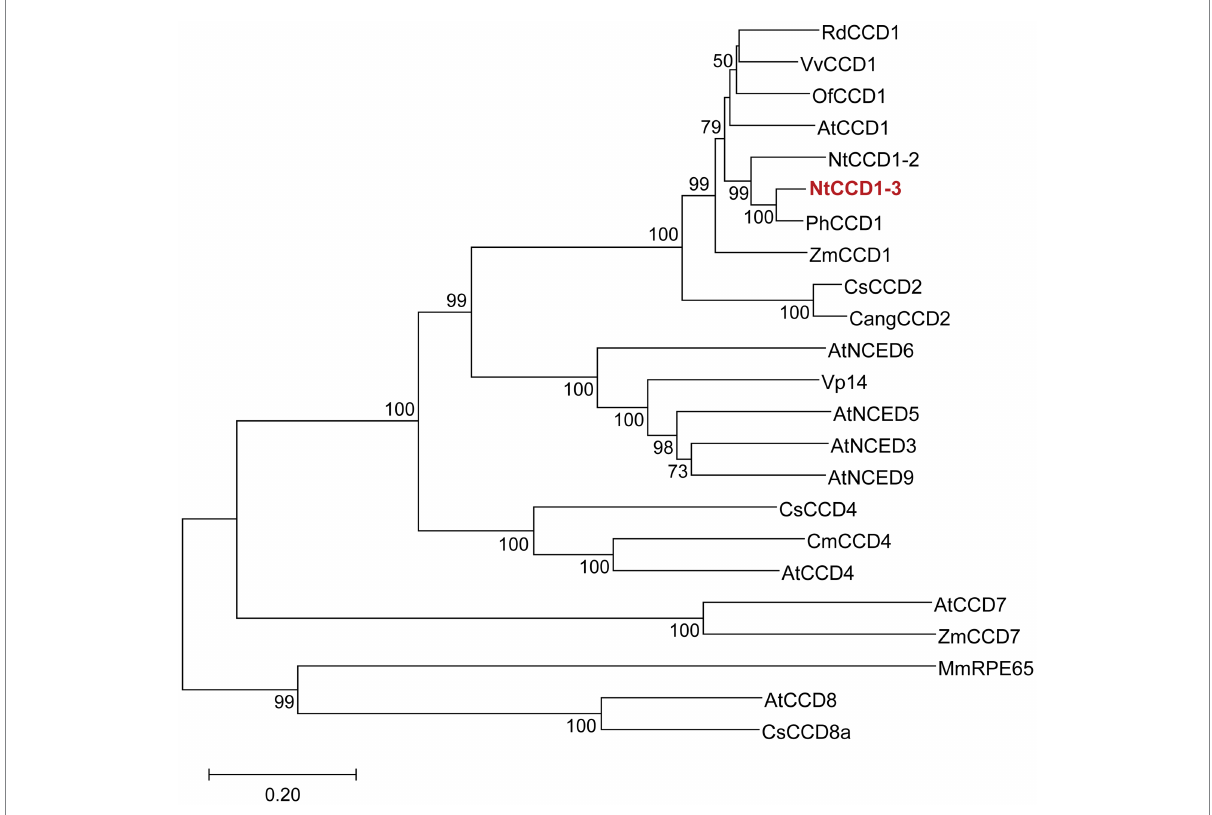
FIGURE 1 Phylogenetic analysis of CCDs from different organisms. NtCCD1-3 is in red and bold. The neighbor joining tree was generated by using MEGA X, based on 1,000 replicates. Bootstrap values above 50 are shown on the branches. The tree scale bar indicates the number of substitutions per site. Rd, Rosa damascena ; Vv, Vitis vinifera ; Of, Osmanthus fragrans ; At, Arabidopsis thaliana ; Nt, Nicotiana tabacum ; Ph, Petunia hybrida ; Zm, Zea mays ; Cs, Crocus sativus ; Cang, Crocus angustifolius ; VP14, Viviparous 14; Cm, Cucumis melo ; Mm, Mus musculus ; RPE65, Retinal pigment epithelial protein 65